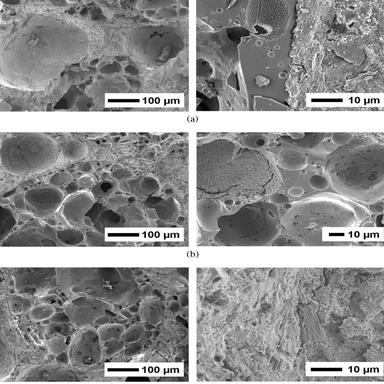
SEM images of the pore and solid structures of lightweight aggregate concrete (LWAC) specimens: (a) LWAC500, (b) LWAC750, (c) LWAC1000.